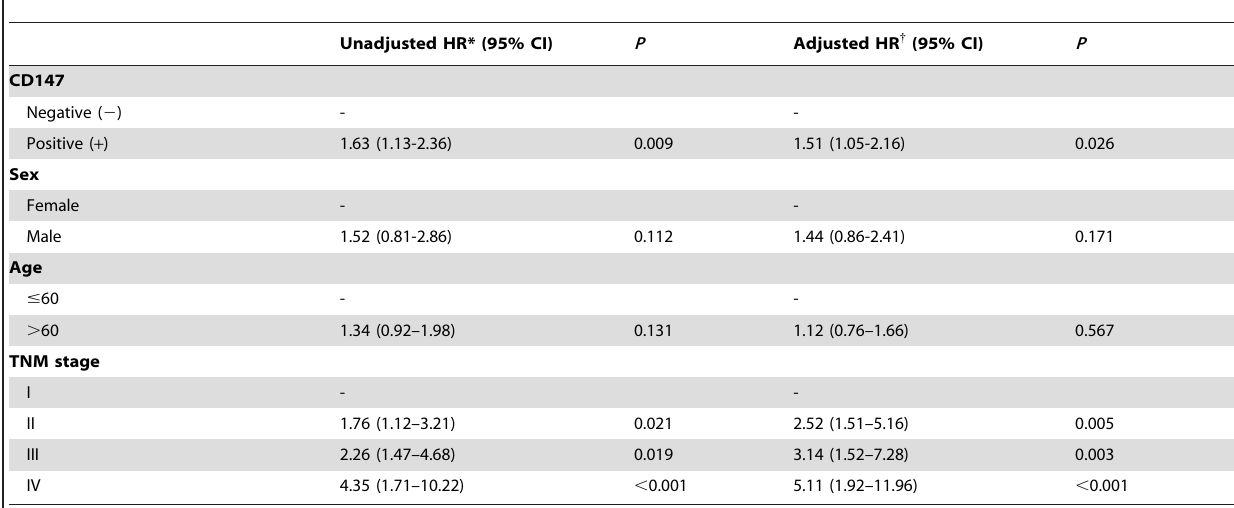
*Hazard ratios in univariate models. { Hazard ratios in multivariable